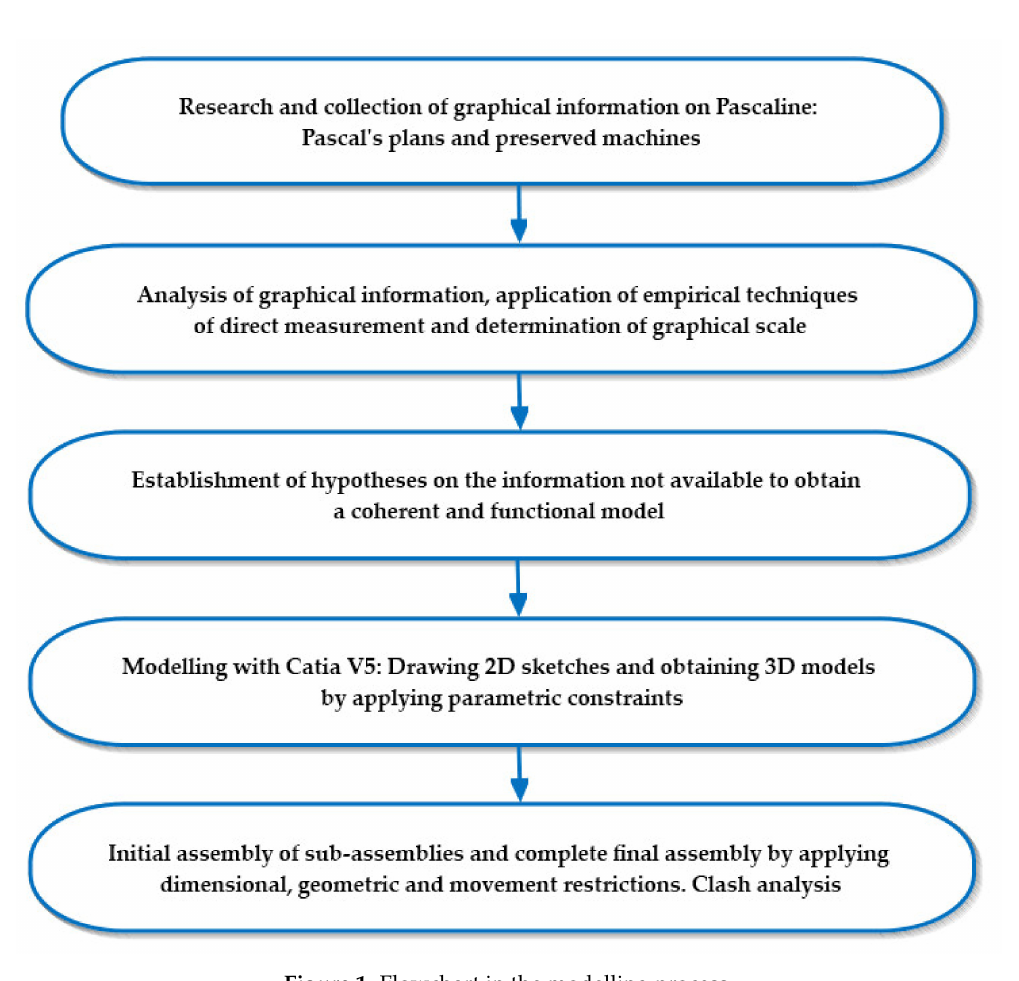
Figure 1. Flowchart in the modelling